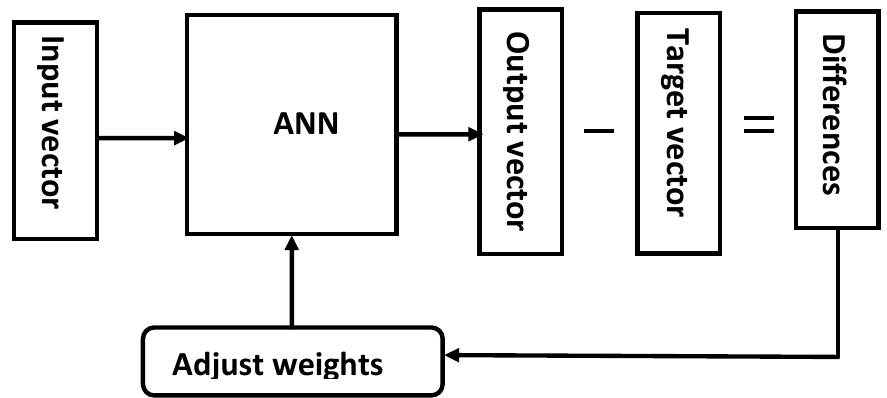
Figure 3. A learning cycle of the artificial neural network (ANN).